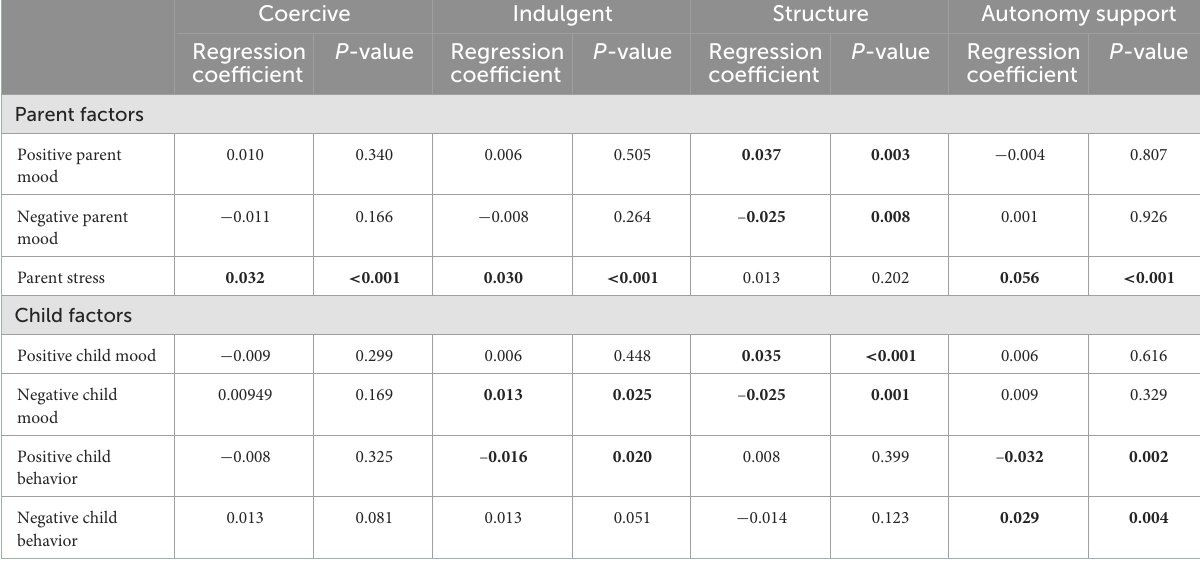
TABLE 3 Adjusted temporal associations between parent- (mood, stress) and child- (mood, behavior) factors early in the day and food parenting practices (coercive, indulgent, structure, autonomy support) later that same day ( n = 109 parent-child pairs; 3,108 eating